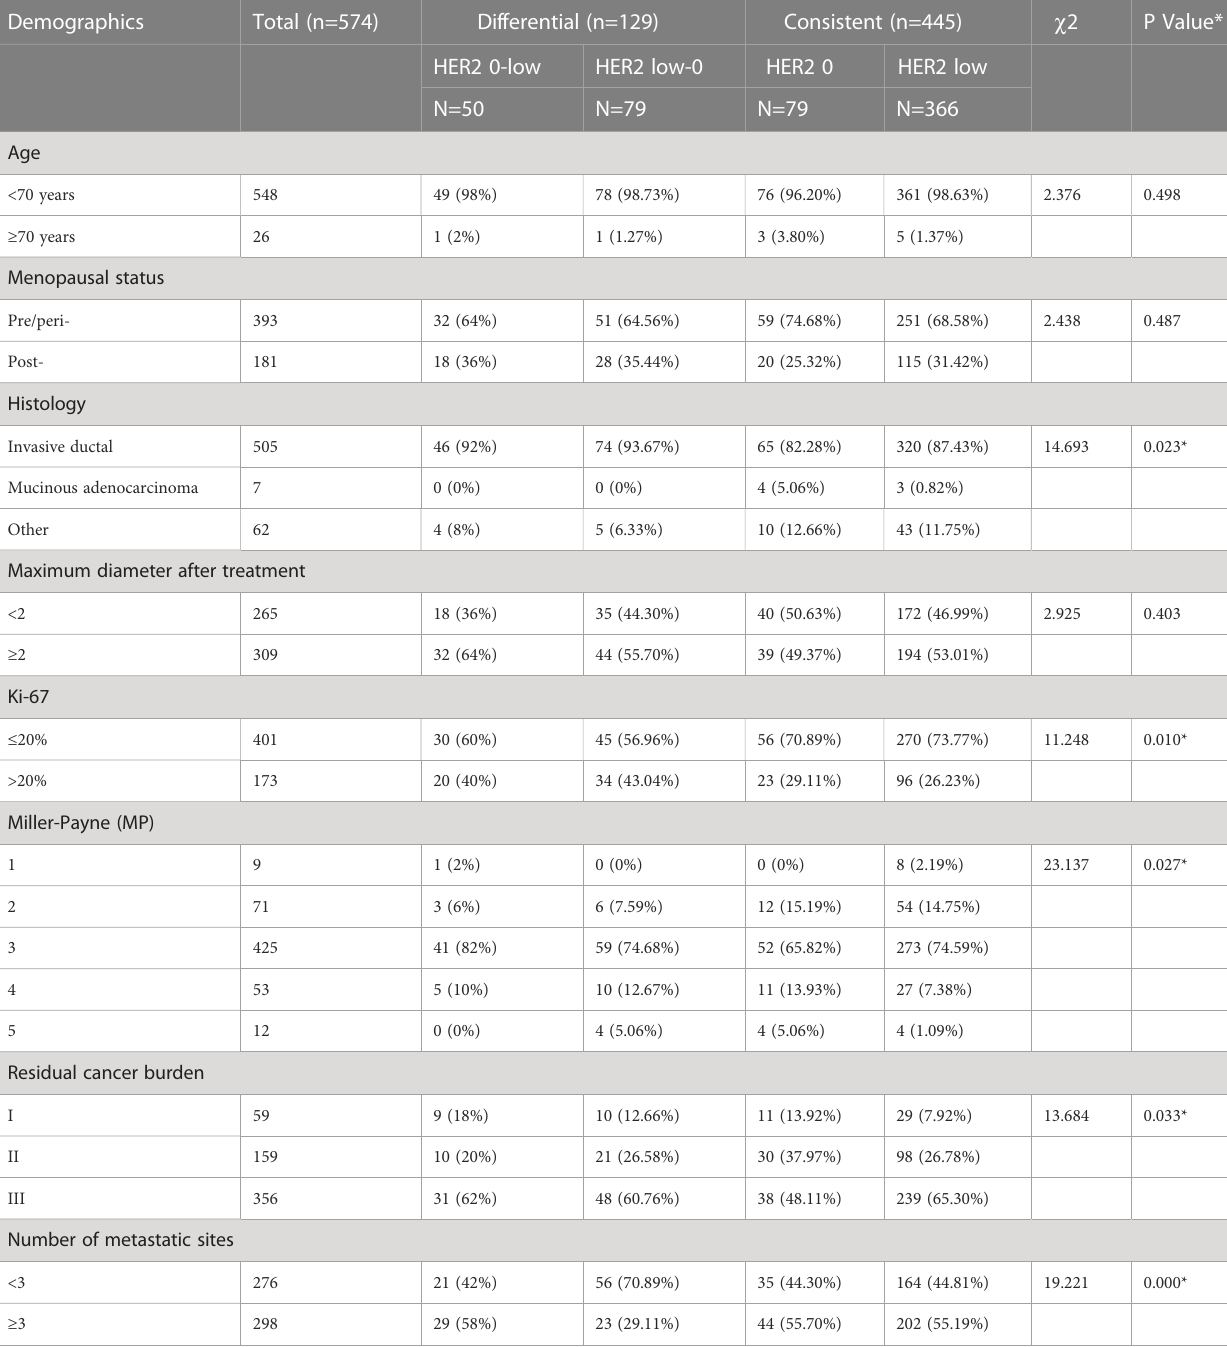
TABLE 7 Baseline patient characteristics strati fi ed by HER2 status evolution (Differential vs.